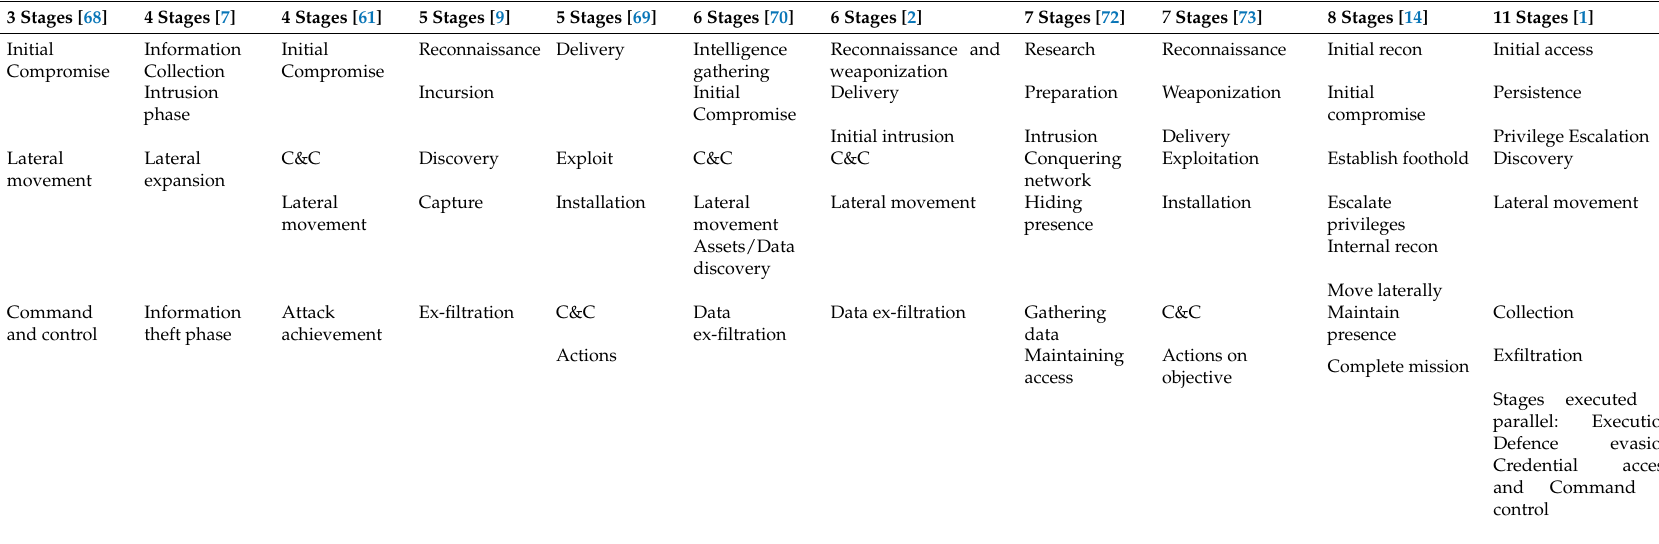
Table 4. Comparison between different proposed APT life cycle